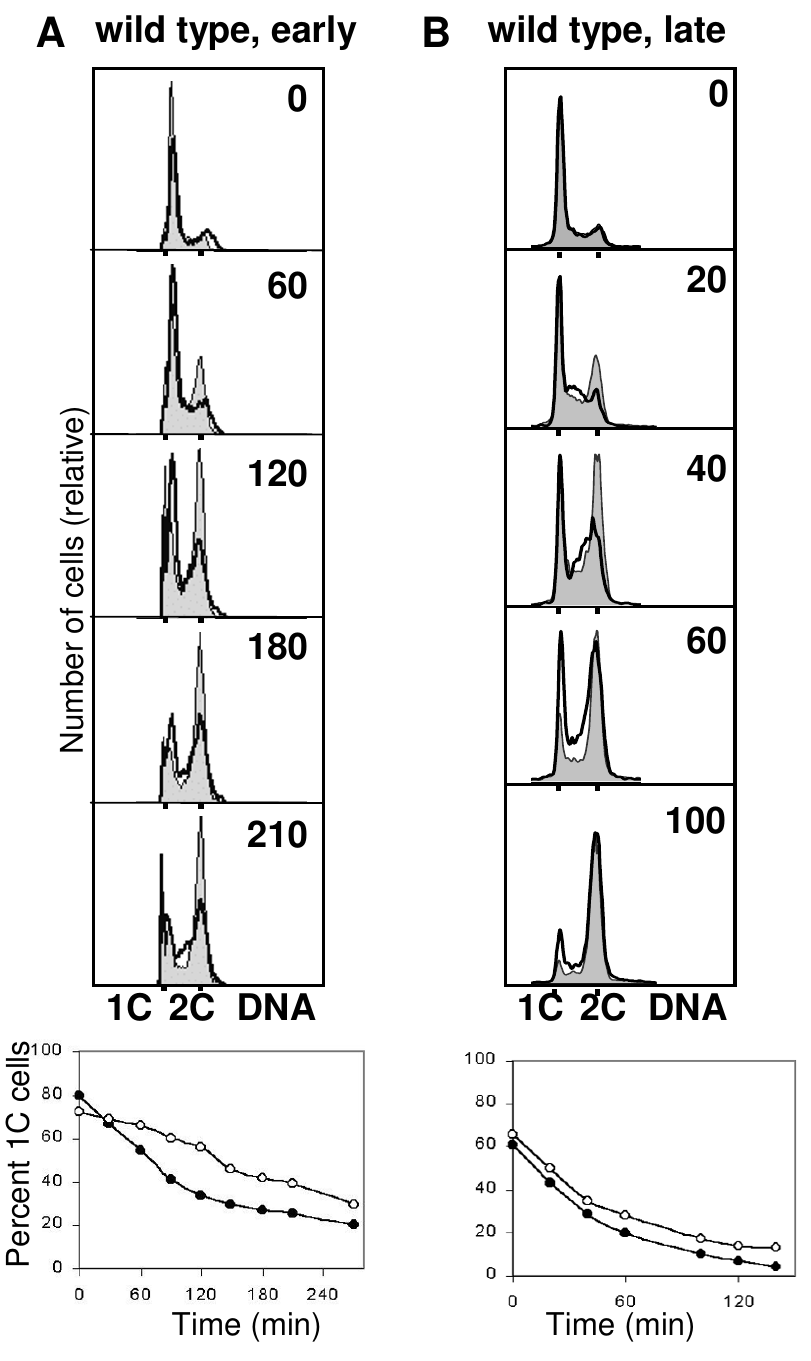
Figure 1 Irradiation of germinating wild type spores delays entry into S phase. Germinating spores were irradiated with UV light 3.5 h ( A ) and 4.5 h ( B ) (time 0) after inoculation into EMM medium, as described in Materials and Methods. Samples were taken for flow cytometry at the indicated times after treatment. The uppper panels show DNA histograms for the unirradiated control (shaded) and the irradiated cells (bold outline without shading). The lower panels show the quantification of cells with a 1C DNA content. Filled symbols represent the control cells, open symbols represent the irradiated